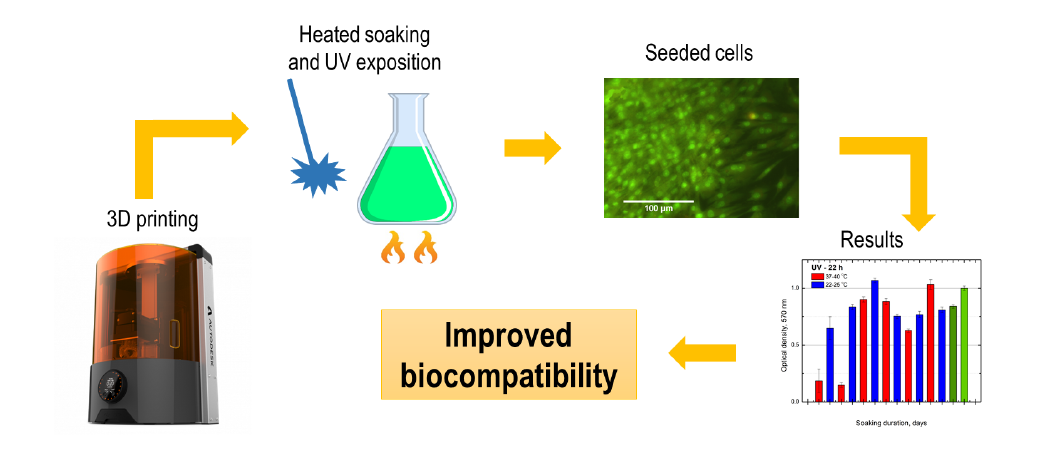
Figure 1. Steps of the experiment: first, samples were 3D printed; secondly, additional UV exposure and heated soaking was implemented; third, samples were seeded with cells and biocompatibility tests were made; and, fourth, results were discussed and conclusions made.